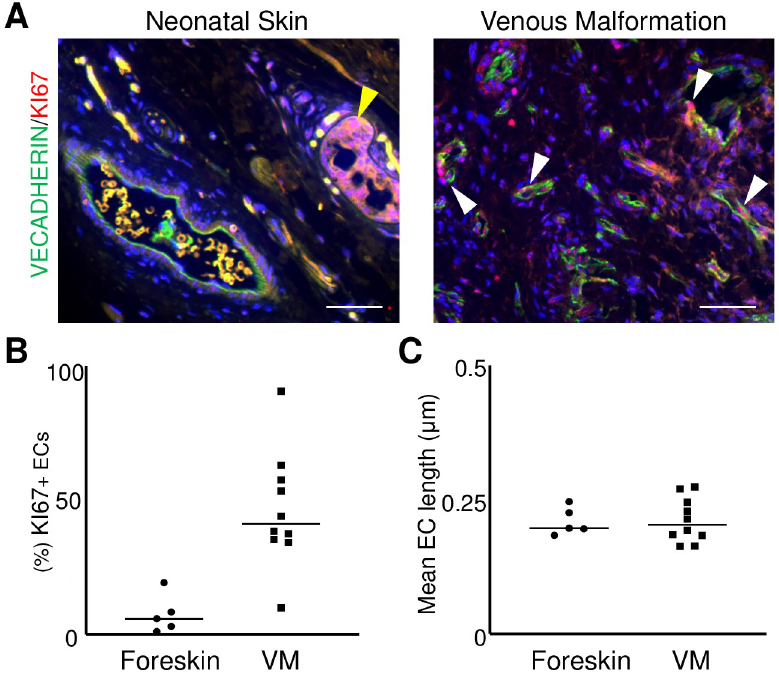
Fig 7. Increased in proliferative ECs in VM vessels. (A) Representative images of VM and control neonatal dermis co-stained for VECADHERIN and KI67. White arrowheads mark VECADHERIN+/KI67+ ECs. Yellow arrowhead marks a KI67+ non-EC in the control. Scale bars—50 μ m. (B) Quantification of percent KI67+ ECs in VMs (n = 10) and controls (n = 5). Bar represents median value, � p < 0.0002. (C) Quantification of EC length in VMs (n = 10) and controls (n = 5). Bar represents median